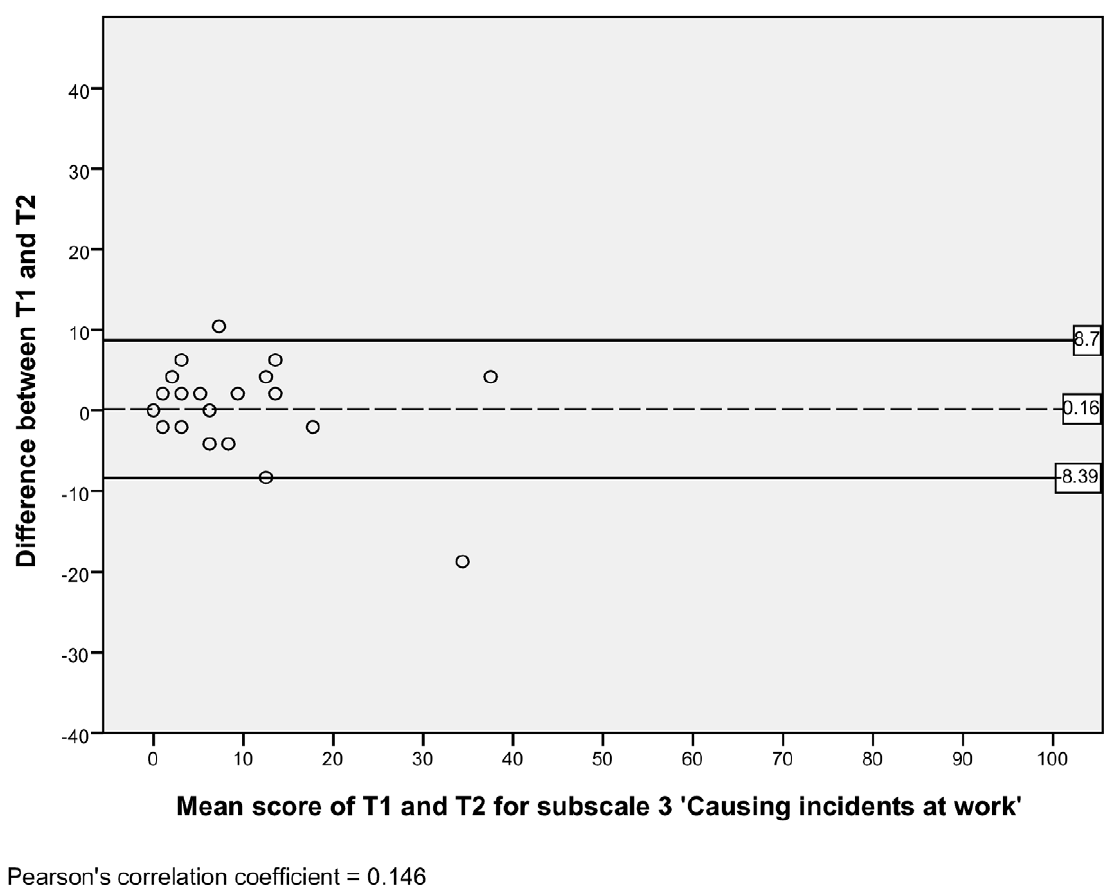
Figure 3. Bland and Altman plot for subscale 3 ‘Causing incidents at work’.